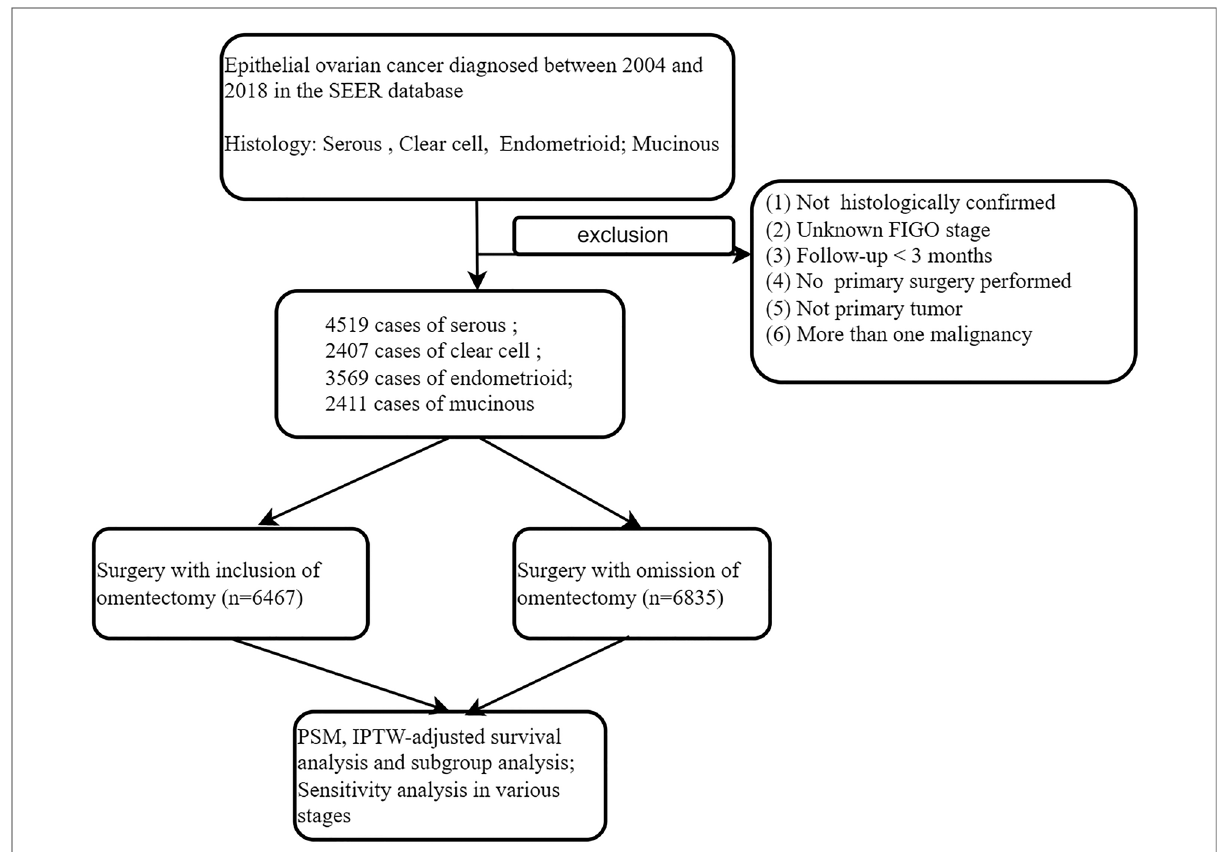
FIGURE 1 Eligibility, inclusion, and exclusion criteria of the study